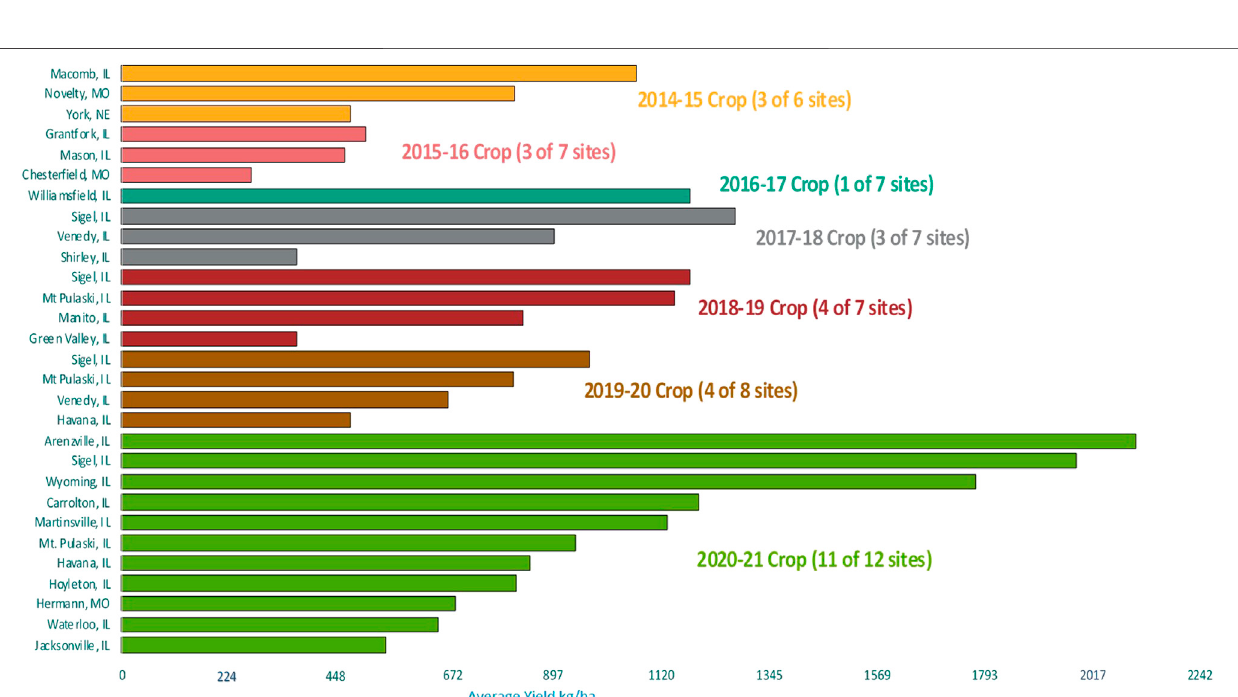
FIGURE 2 | Multi-year and multi-location yield data demonstrating signi fi cant seed yield increases of CoverCress ™ through traditional plant breeding and gene- editing.